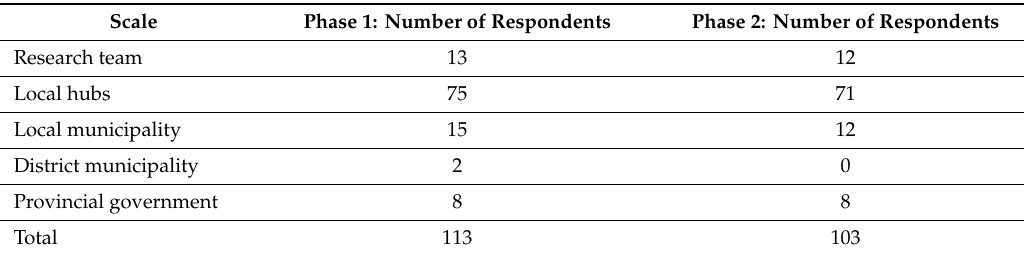
Table 1. Characterisation and distribution of organisational